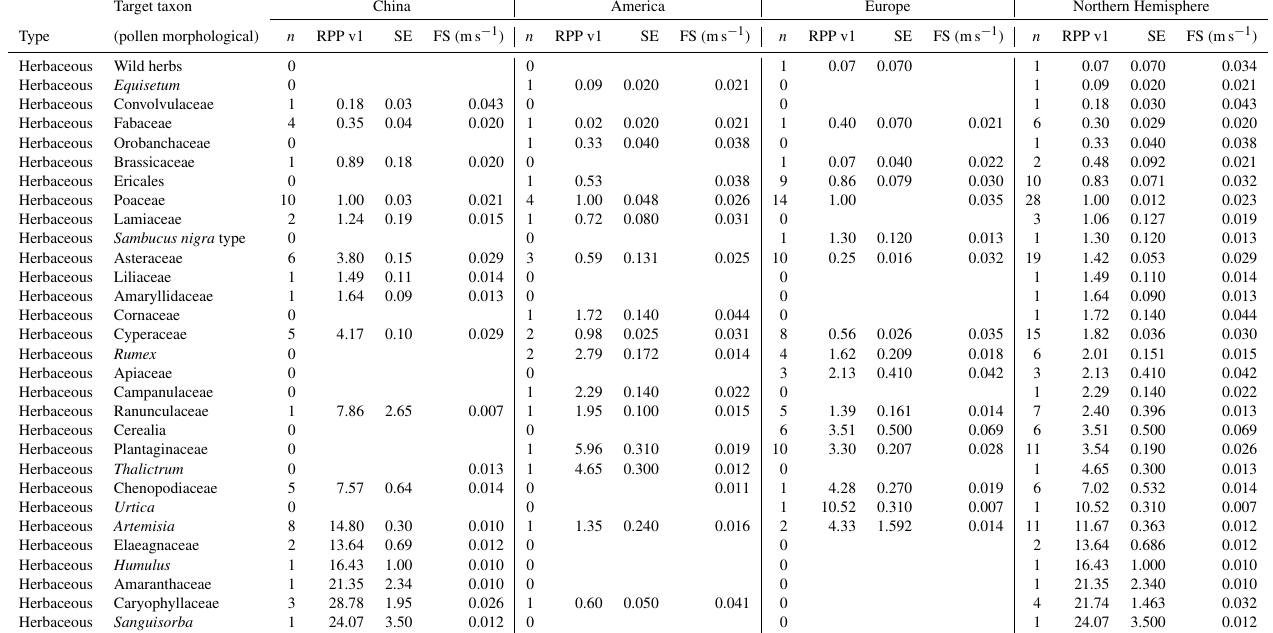
Table 4. Overview of continental and northern hemispheric relative pollen productivity (RPP) values for herbaceous vegetation with their standard error (SE) (dataset v1) and fall speeds. All values are relative to Poaceae. See Table A1 for information on original RPP data, Table A4 for information on original fall speed values, and methods on the creation of dataset v1 (Wieczorek and Herzschuh, 2020, https: //doi.org/10.1594/PANGAEA.922661). The group of wild herbs is taken from the publication of Matthias et al. (2012) and consists of uncultivated terrestrial herb pollen, including Poaceae, Plantago lanceolata , Rumex acetosa , R. acemsella , and